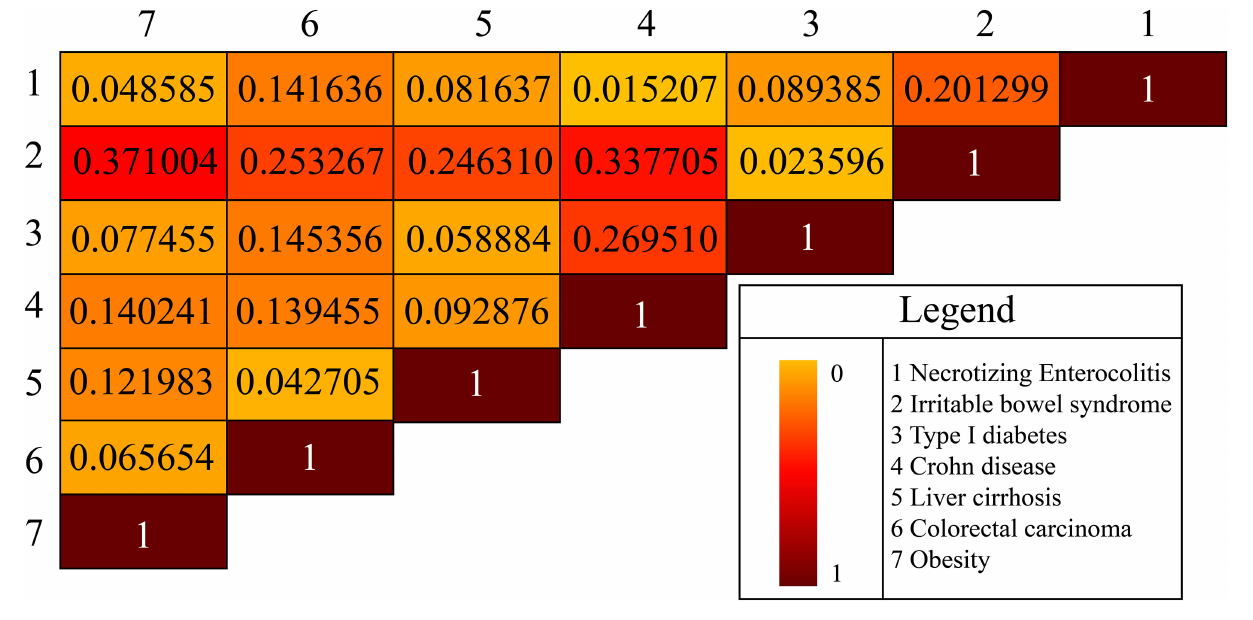
FIGURE 3 | The disease-disease association is based on microbial natural products. There are seven diseases in